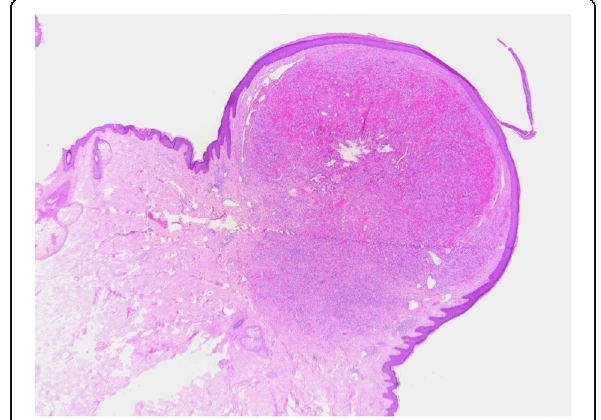
Fig. 1 CEAN from case 1 showing a typically polypoid lesion with a well-circumscribed vascular dermal nodule. There is a suggestion of a collarette at the edges of the lesion simulating pyogenic granuloma